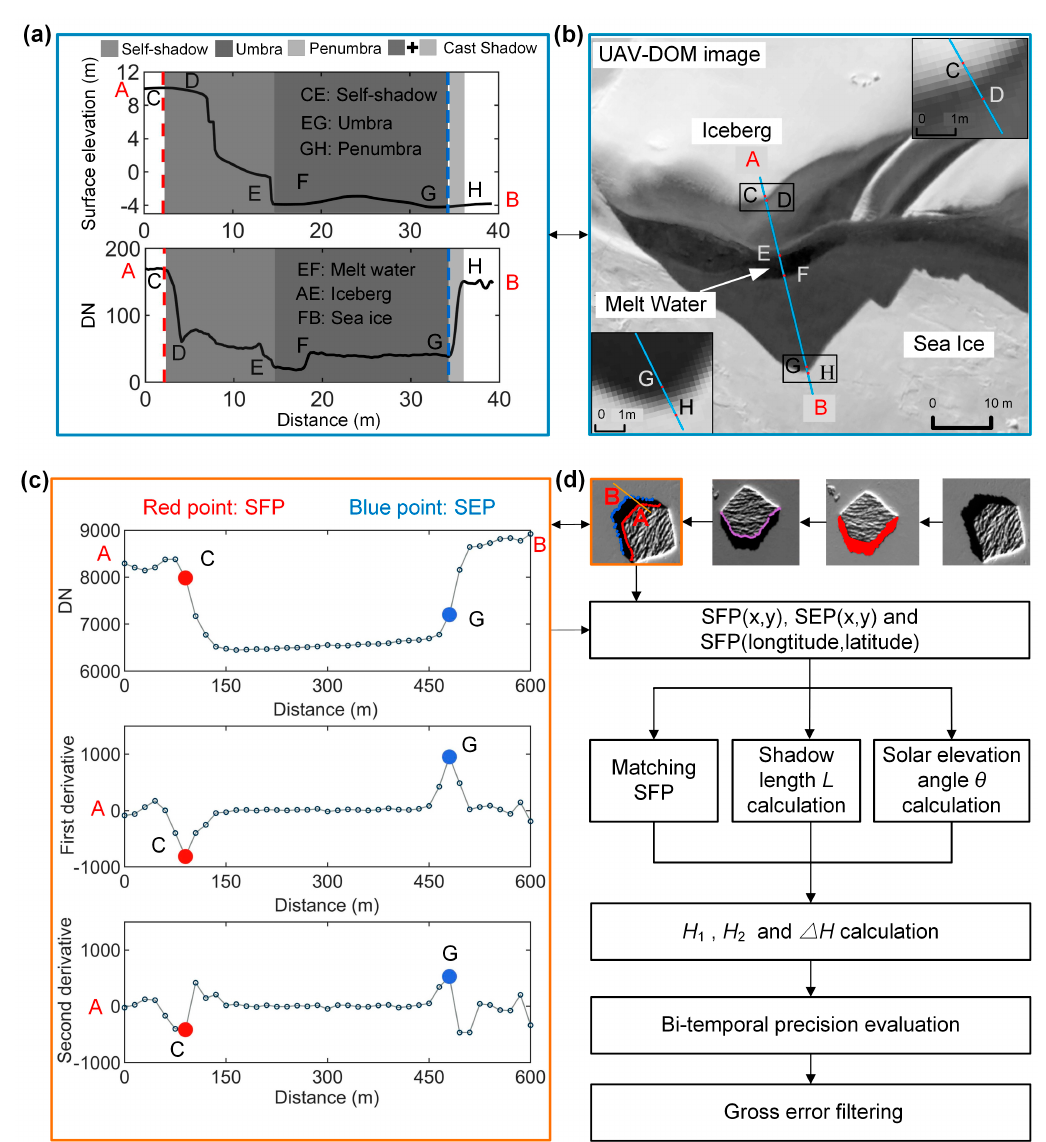
Figure 2. Flowchart of shadow extraction and iceberg freeboard estimation from bi-temporal Landsat-8 panchromatic remote-sensing images. ( a ) The elevation and grayscale profile of the blue line in ( b ), the red vertical dashed line is the grayscale value corresponding to the highest point of the iceberg, DN C-D : Affected possibly by diffraction light; DN D-G : Objects’ different reflection of scattering light. Dark gray areas are the umbra, light gray areas are the penumbra. ( b ) UAV-DOM image. Combined with ( a ), ( b ) it follows that: AE: Iceberg, EF: Meltwater, FB: Sea ice. ( c ) Location of the shadow formation points (SFPs) and the shadow edge points (SEPs) of the Landsat-8 image determined by our method, which is essentially the same as the position of the shadow determined in ( a ). The red point is the SFP, and the blue point is the SEP. ( d ) Iceberg freeboard estimation algorithm flowchart.